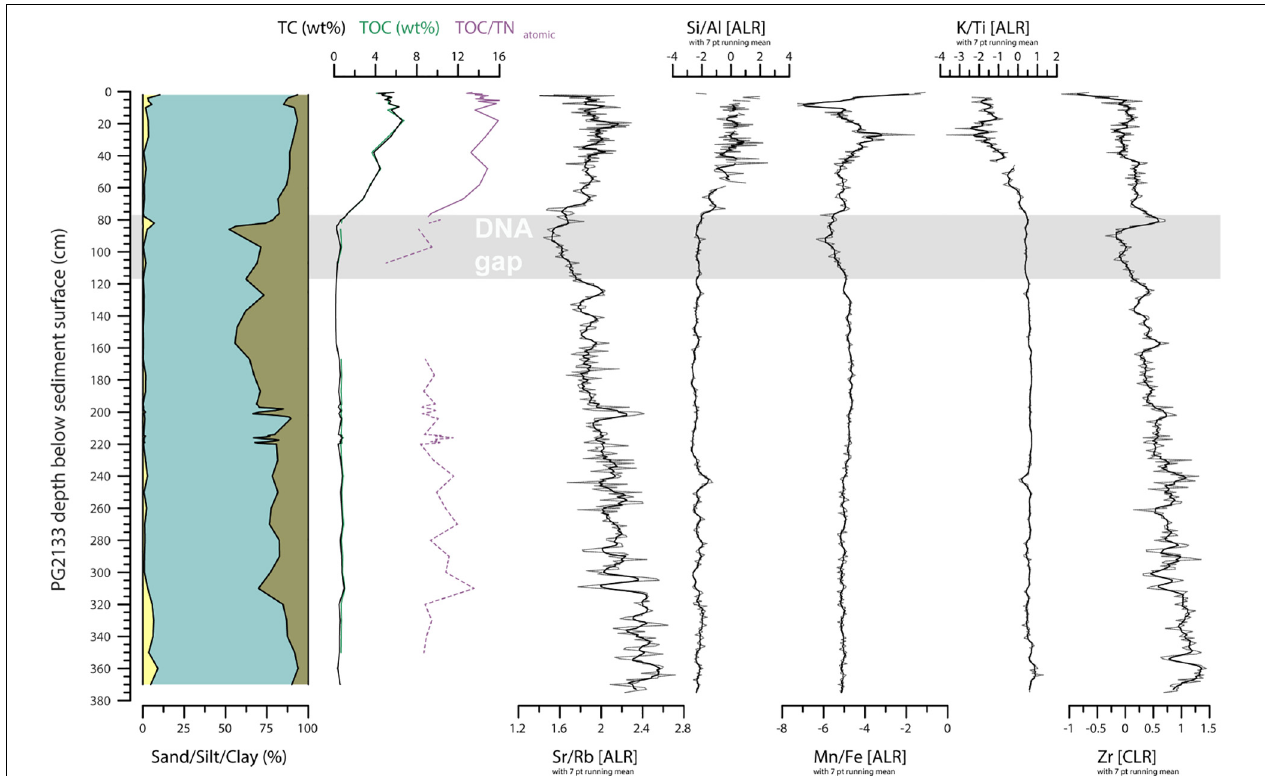
FIGURE 3 | Sedimentary and geochemical composition of sediment core PG2133 including grain-size distribution, carbon concentrations, and XRF elements. Sand, silt, and clay proportions are reported over the entire PG2133 core. Total carbon (TC), total organic carbon (TOC), and the ratio of TOC to nitrogen (TOC/TN atomic ) are reported to indicate input of terrestrial plant material relative to aquatic algae (Meyers, 2003; Biskaborn et al., 2012). The Strontium (Sr) over Rubidium (Rb) ratio and Zirconium (Zr) indicate relative detrital input related to coarse grain size (Biskaborn et al., 2013). The Silicon (Si) over Aluminum (Al) ratio indicates the occurrence of diatom valves (Vyse et al., 2020). The Manganese (Mn) and Iron (Fe) ratio indicate redox dynamics associated with bottom water oxygenation (Melles et al., 2012; Naeher et al., 2013), which with the Potassium (K) over Titanium (Ti) ratio, provides information on physical versus chemical weathering in the catchment (Vyse et al., 2020). Shaded area indicates a gap in the DNA